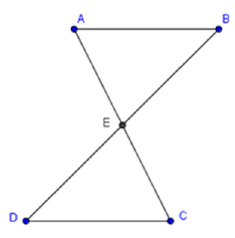
Figure 9. Figure of Task 2.